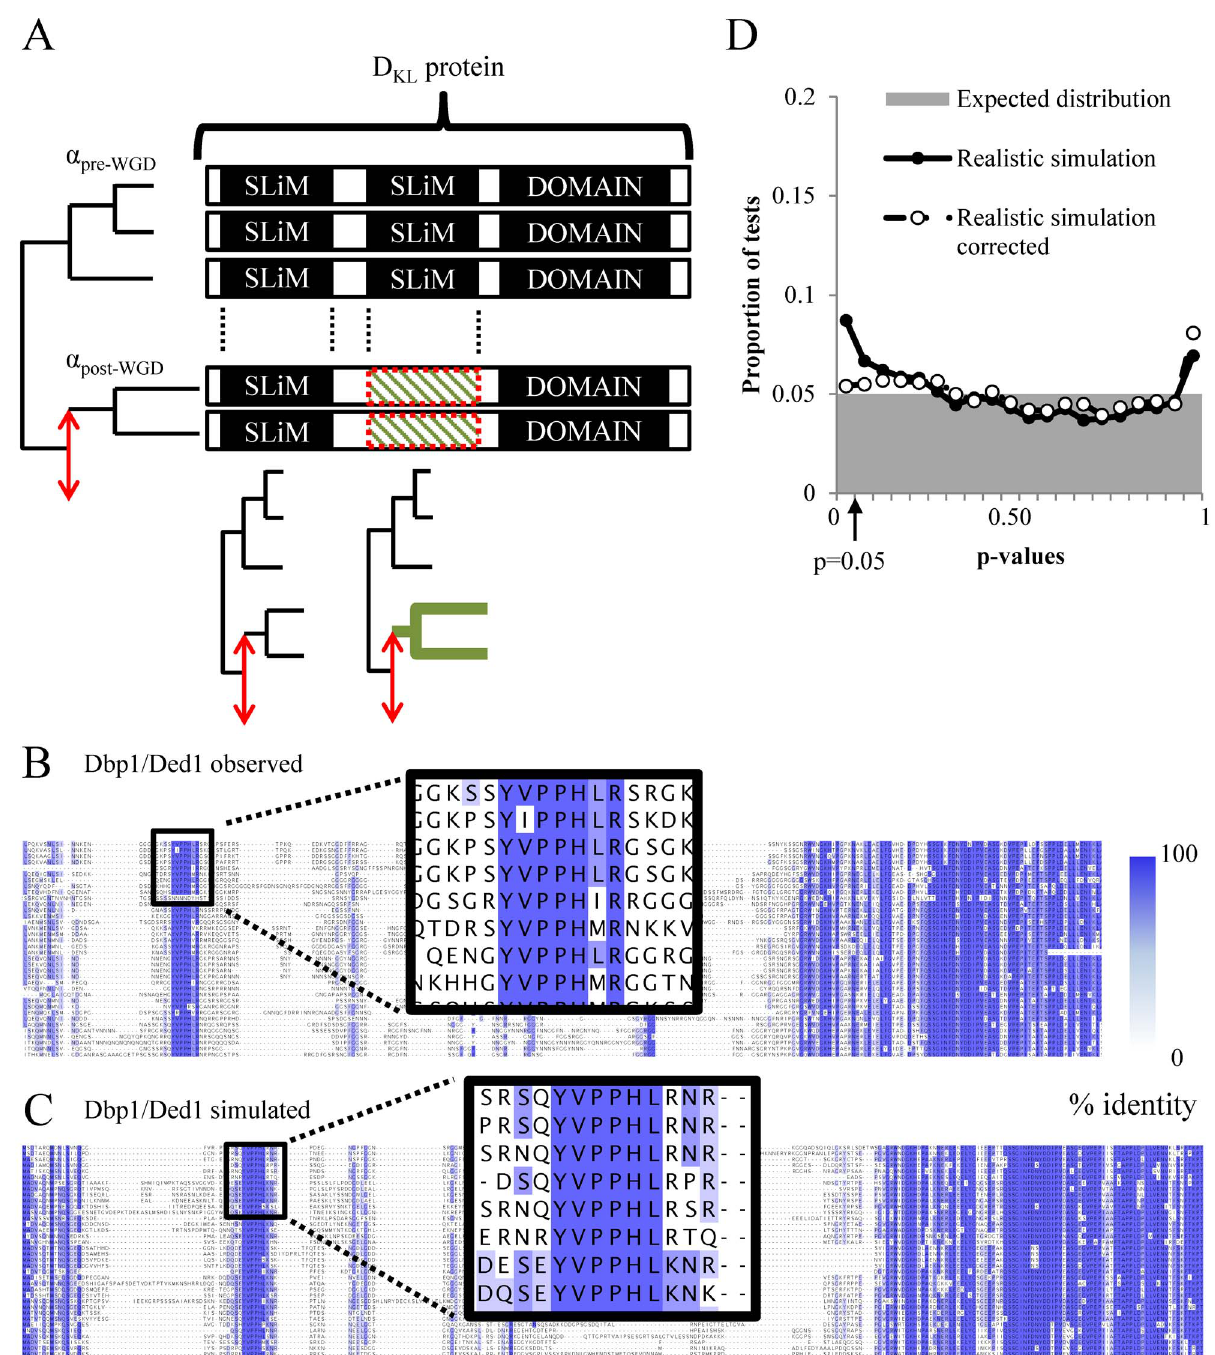
Fig. 1. Likelihood-ratio test on short linear motifs after gene duplication on simulated data . A) Schematic of the motif-specific likelihood- ratio test applied to all motifs. Rates of evolution are computed for each motif before ( a pre-WGD ) and after ( a WGD ) gene duplication and compared with the rates that were observed for the whole protein (see Methods). Red double arrow illustrates the duplication event. Bolded clades are clades with significant changes in constraints. Striped patterned boxes indicate short linear motifs with significantly different rate of evolution. D KL indicates the expected deviation of the likelihood-ratio test from the whole protein. B) Alignment of the N-terminus of the Dbp1/Ded1 homologs illustrates the rate heterogeneity amongst columns and highlights the short length of a putative motif (black rectangle zoom). Blue shade represents the percentage identity. C) Alignment of the N-terminus of a simulated protein based on Dbp1/Ded1 using our ‘realistic’ simulation of evolution (see Methods). D) Histogram shows the p-value distribution obtained from set of protein sequences that were evolved as in C). Grey shaded area indicates the expected proportion of tests. Circles indicate the distribution of p-values obtained from the likelihood-ratio test described in A) when the test statistic is assumed to be chi-squared distributed (black circles) or non-central chi-squared distributed (white circles, ‘‘corrected’’).